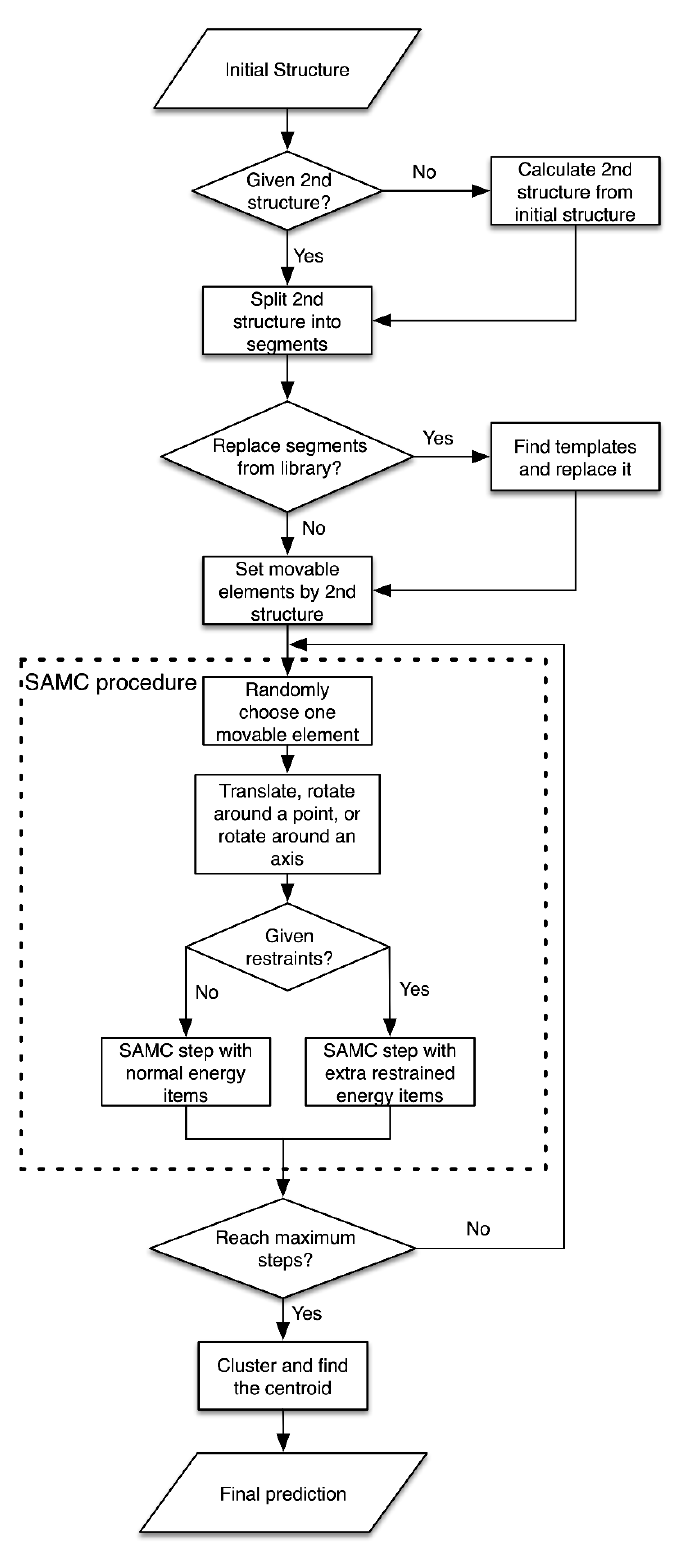
Figure 2. The flowchart of optimization procedure in 3dRNA. SAMC—simulated annealing Monte Carlo sampling method.